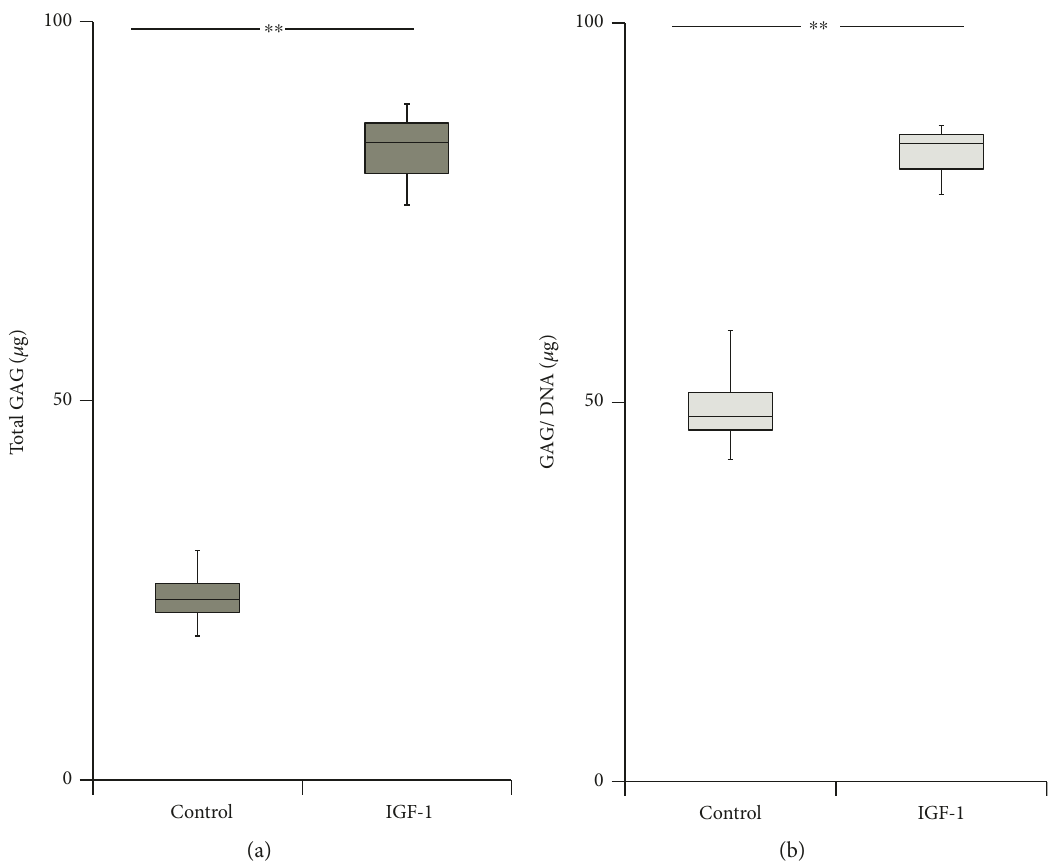
Figure 2: Gross and DNA-corrected glycosaminoglycan (GAG) content of pellet cultures (in μ g). The pellets were analyzed for GAG after 14 days in the di ff erentiation medium using a Blyscan sulfated GAG assay kit. Control values (left) versus IGF-1 gene transfer values (right). (a) Box plot of gross GAG content of the pellet cultures. (b) Box plot of DNA-corrected GAG content. ∗∗ p < 0 01